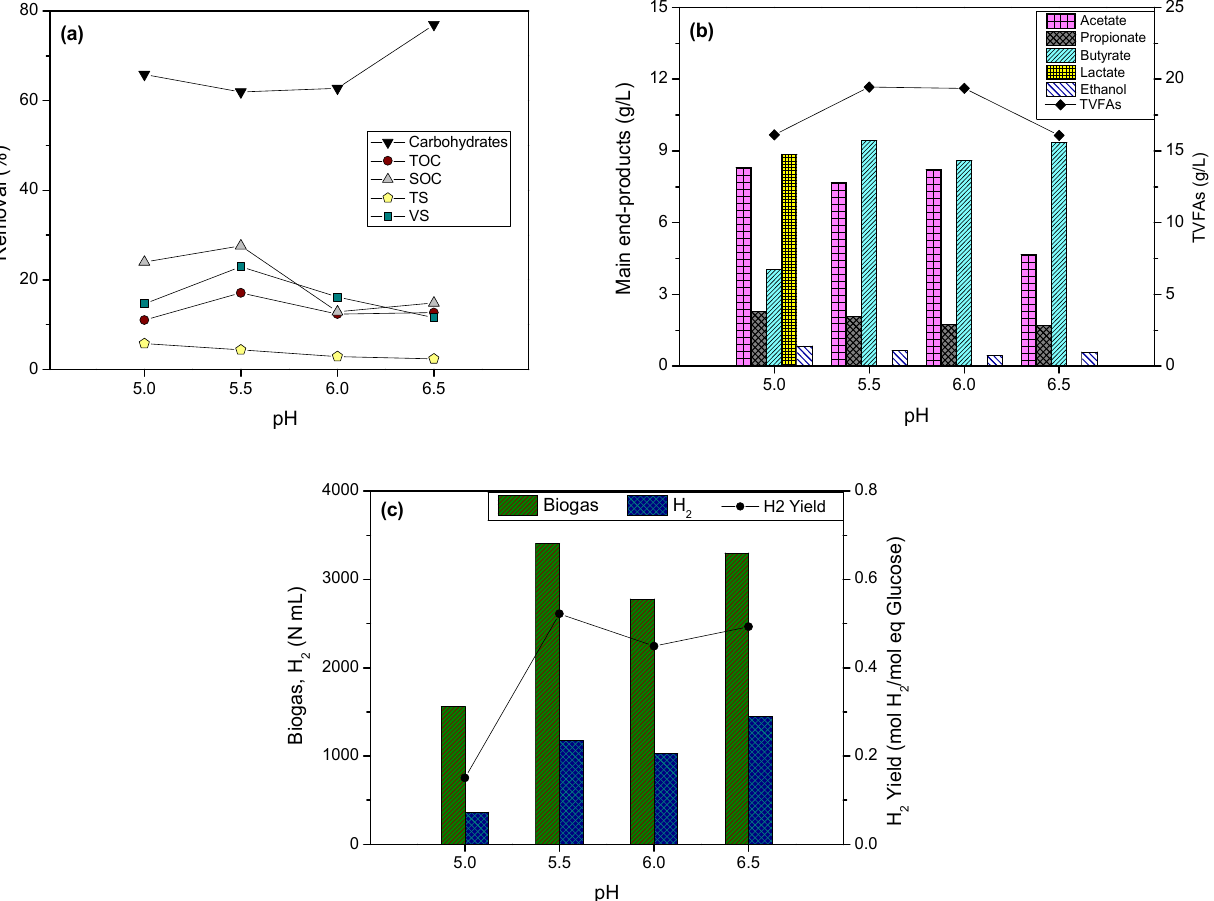
Figure 2. Effect of pH on ( a ) carbohydrates, TOC, SOC, TS, VS removal; ( b ) main soluble end-products; ( c ) biogas and hydrogen production and hydrogen yield.